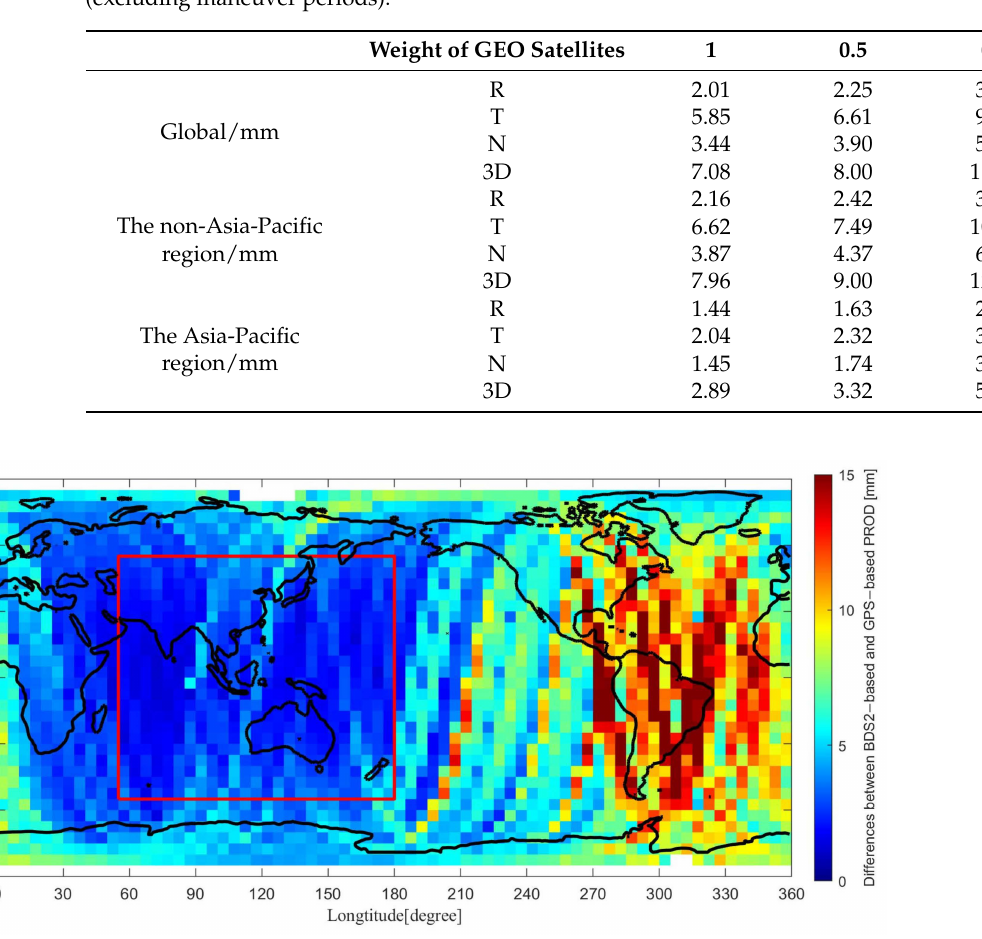
Figure 9. Global distribution of difference between the GPS-based and BDS2-based PROD in 3D components (excluding maneuver